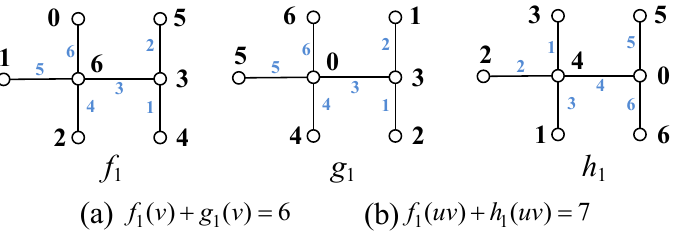
Figure 1. A tree T admits: ( a ) a matching of set-ordered graceful v-image-labelings f 1 and g 1 , ( b ) a matching of set-ordered graceful e-image-labelings f 1 and h 1